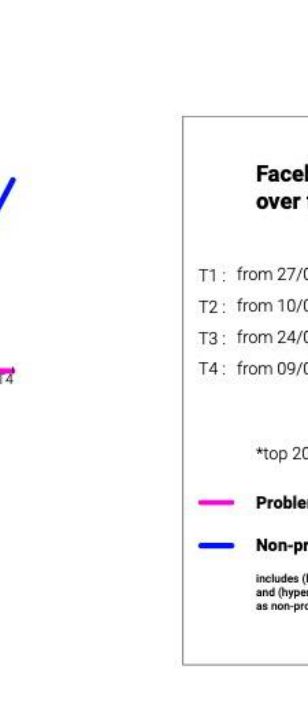
Figure 3. Facebook engagement scores of ‘fake news’ (narrow definition) versus mainstream news for political candidate and social issue queries overall, January 27 – March 23, 2020. Source: